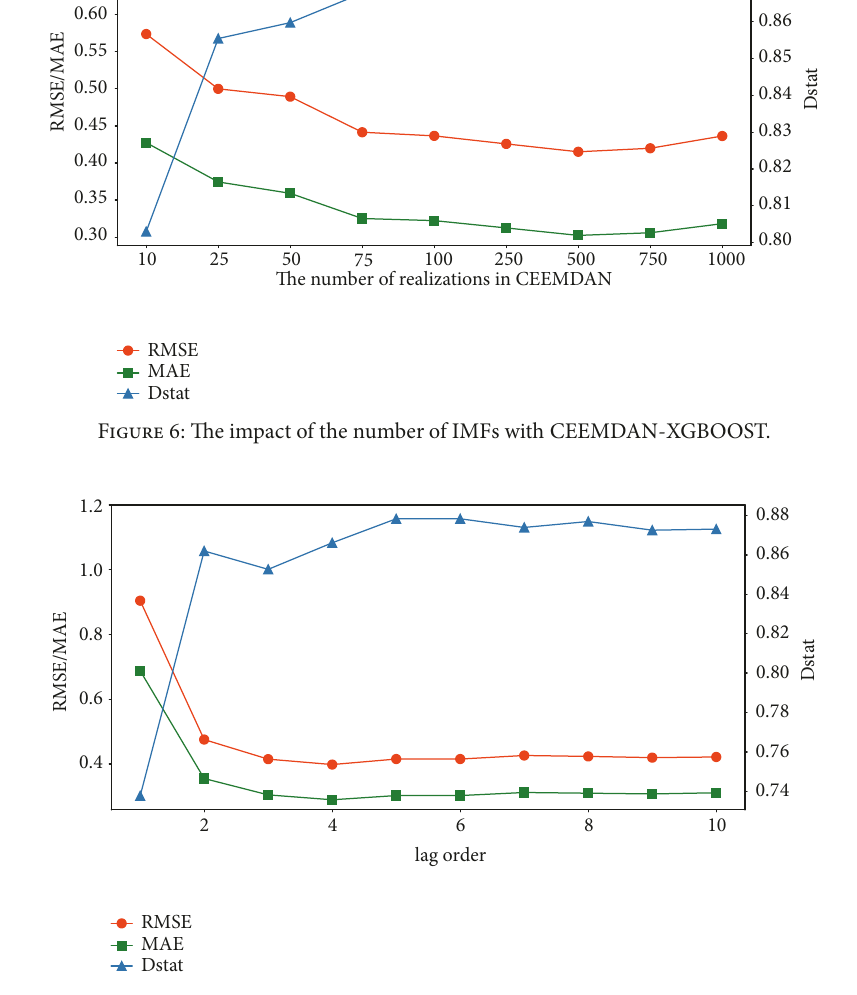
Figure 7: The impact of the number of lag orders with CEEMDAN-XGBOOST.